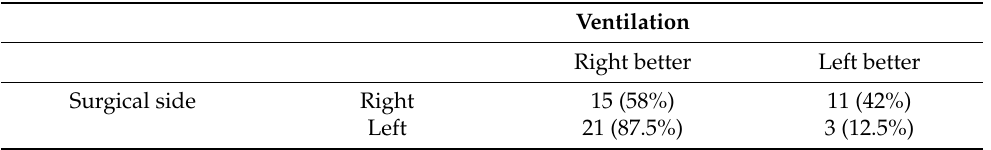
Table 3. Ventilation distribution of the lungs bilaterally at Ev. 3 (the preoperative lateral decubi- tus